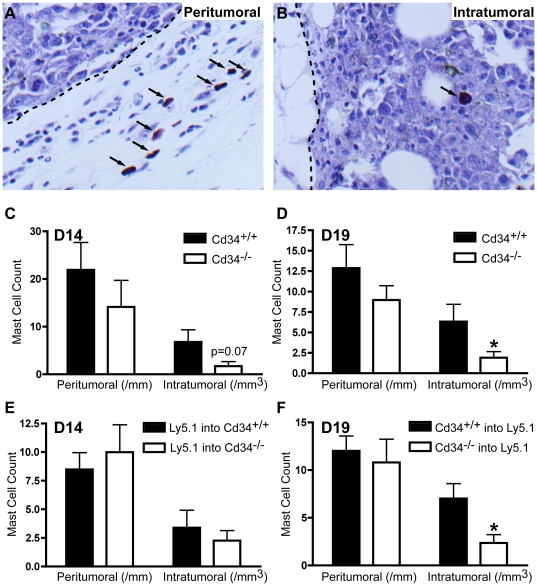
Mast cell tumor infiltration is reduced in Cd34−/− mice.Toluidine blue staining of A, peri-tumoral mast cells in tissues surrounding tumors and B, intra-tumoral mast cells within tumor tissues. (arrows, mast cells; dotted line, tumor boundary). Mast cell counts in s.c.-injected tumors from Cd34+/+ and Cd34−/− animals at C, day 14 (pooled from three experiments, Cd34+/+ n = 13, Cd34−/− n = 16) and D, day 19 (pooled from three experiments, n = 13). Counts in tumors from E, Cd34+/+ or Cd34−/− animals reconstituted with wildtype Ly5.1 marrow at day 14 (pooled from three experiments, Ly5.1 into Cd34+/+ n = 13, Ly5.1 into Cd34−/− n = 14) and F, in wildtype Ly5.1 animals reconstituted with either Cd34+/+ or Cd34−/− bone marrow at day 19 (pooled from three experiments, Cd34+/+ into Ly5.1 n = 11, Cd34−/− into Ly5.1 n = 13). (*represents p<0.05; Error bars = SEM).